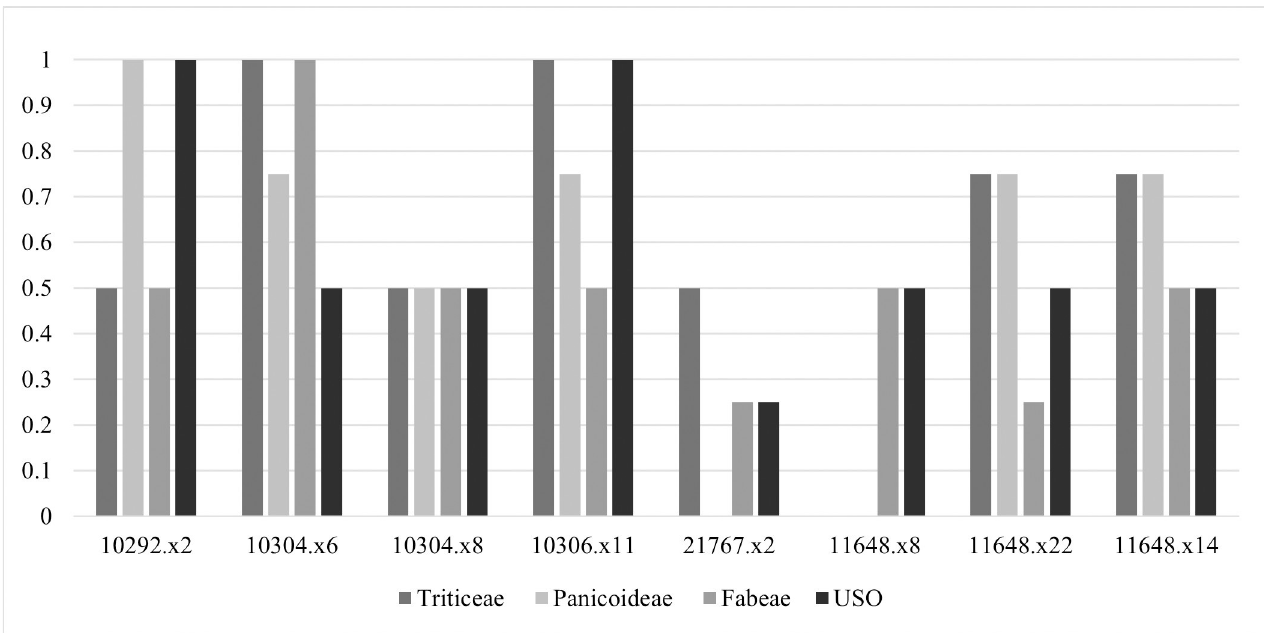
Fig 5. Starch ubiquity by artefact. Based on the presence and absence of starch taxonomic groups on each artefact.